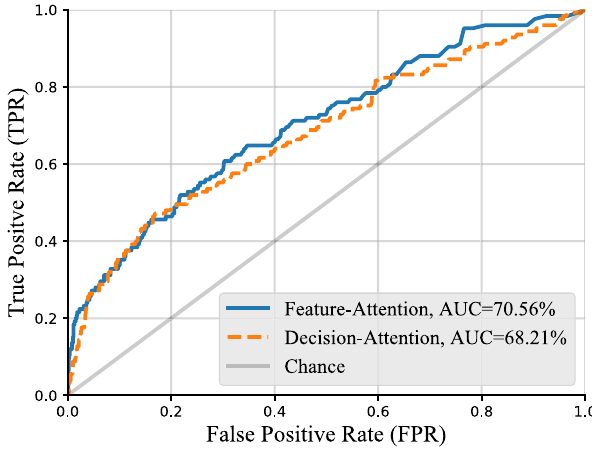
Figure 2. The average ROC curves of the attention-based ensemble learning on the validation